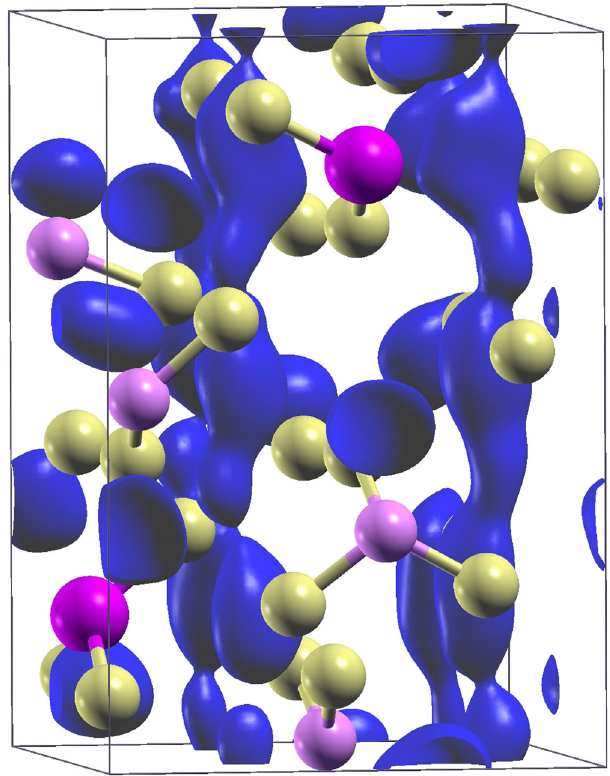
Fig. 2 Li-ion probability density in t-LGPS from the 600 K- NPT CP molecular dynamics trajectory (0.08 Å − 3 isovalues, blue isosur- face). The equilibrium positions of sulfur, germanium, and phos- phorus are shown as yellow, pink, and light rose spheres, respectively, and Ge − S and P − S bonds are displayed. Analogous Li-ion probability density isosurfaces are reported for o-LGPS, t- LGPO, and o-LGPO in Supplementary Figure 6.